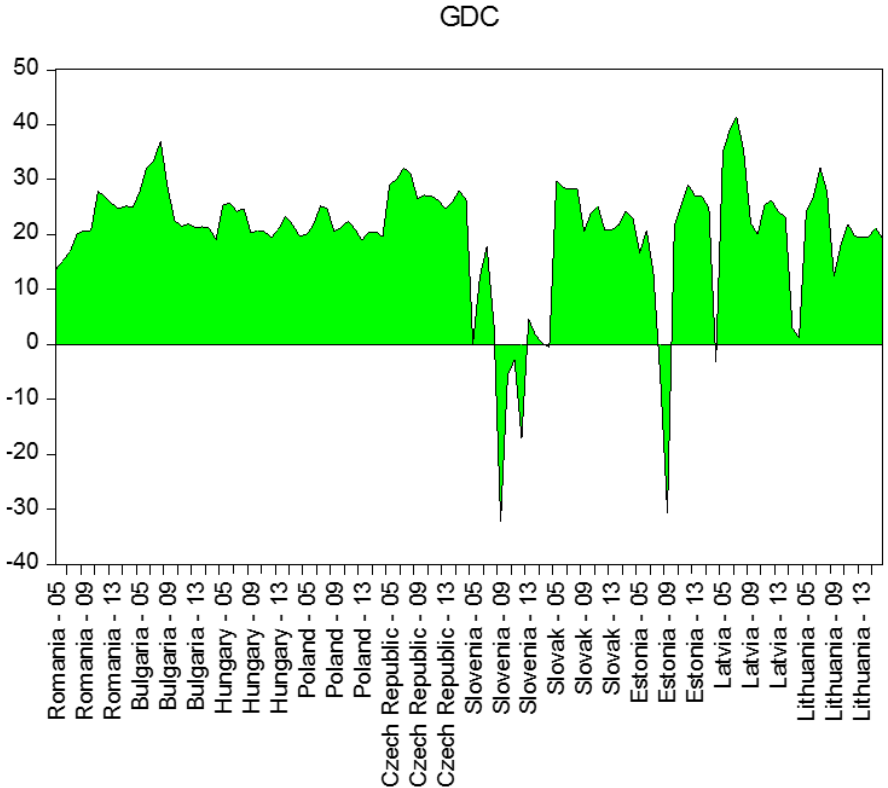
Figure 4. Gross domestic capital (GDC) annual percentage change in CEE countries.